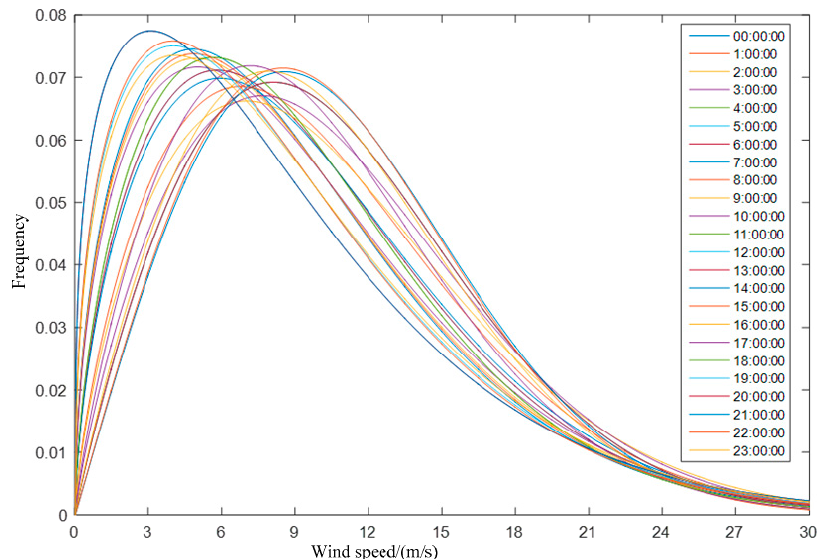
Figure 2. The PDF of wind speed in 24 h.